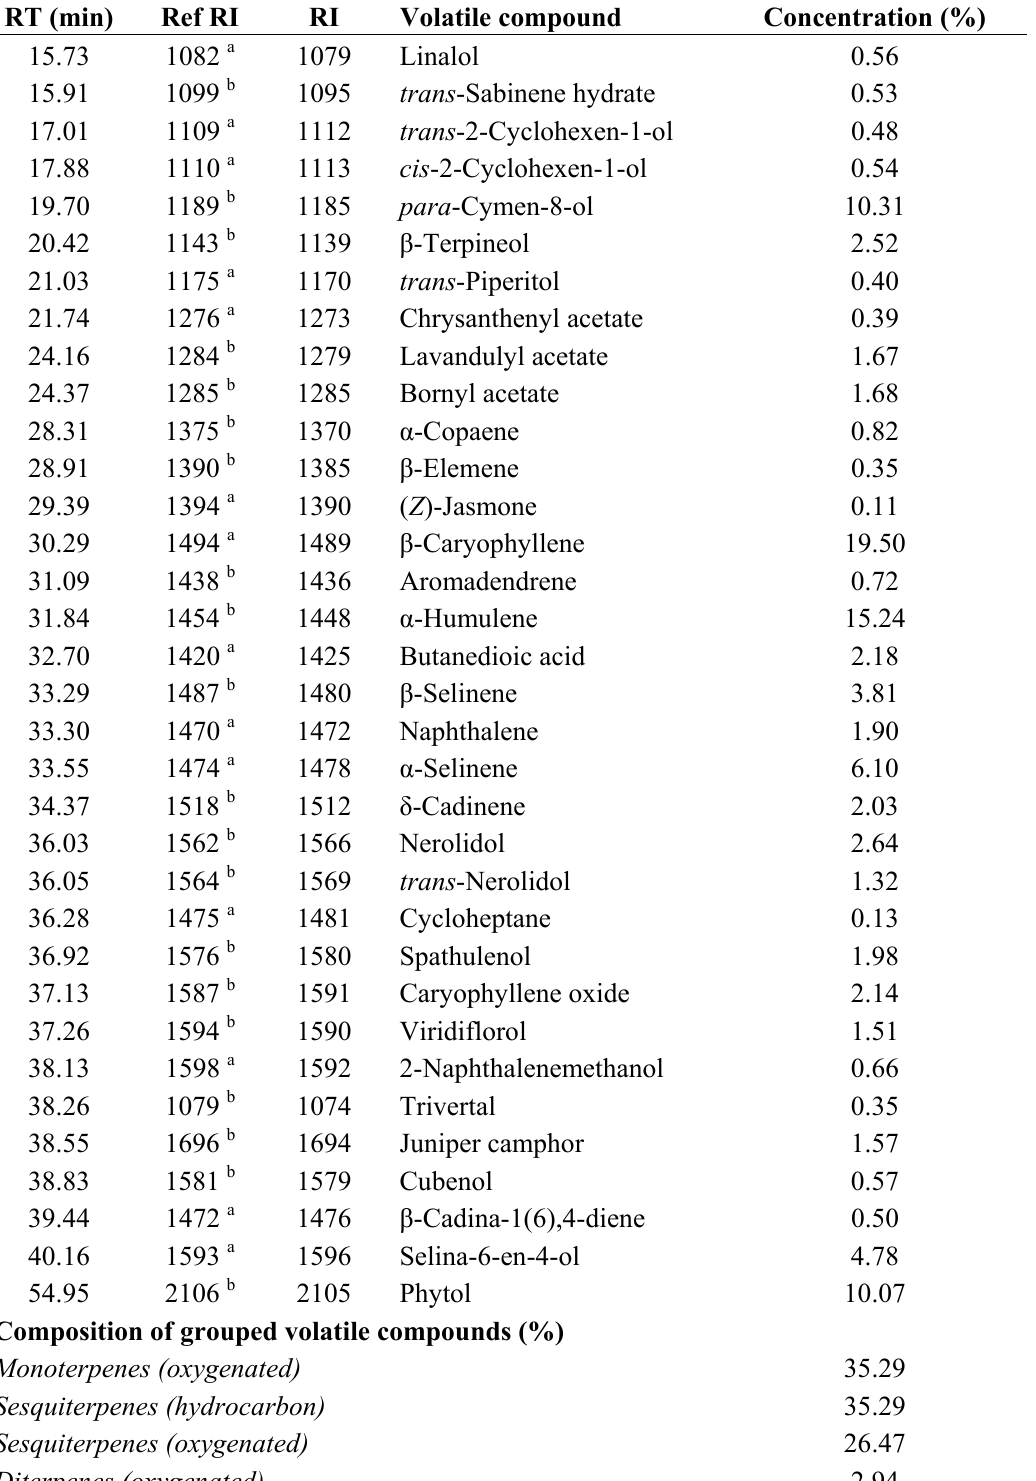
Table 2. Composition (%) of volatile compounds in essential oil of Murraya koenigii from Sabah,